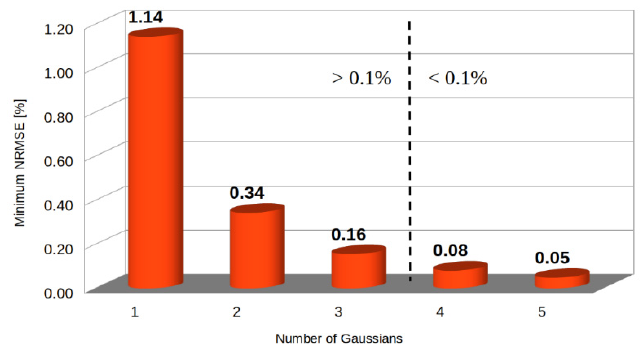
Figure 2. Optimal number of Gaussian functions, chosen with the 0.1% NRSME criterion.